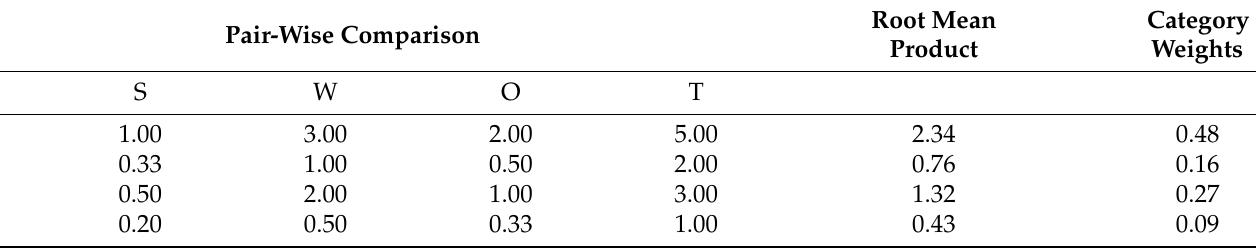
Table 12. Determination of weights of the SWOT